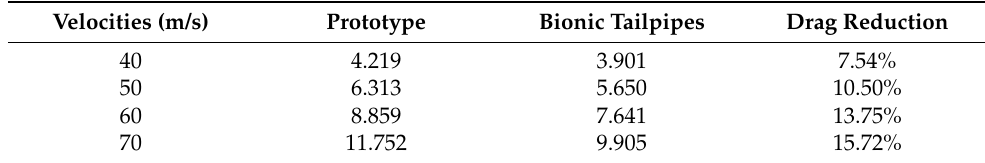
Figure 18. Vorticity amplitude nephogram ( a ) prototype ( b ) bionic tailpipe. Prototype: ( a ) sound pressure level amplitude nephogram, ( b ) velocity amplitude nephogram, and ( c ) velocity vector diagram.